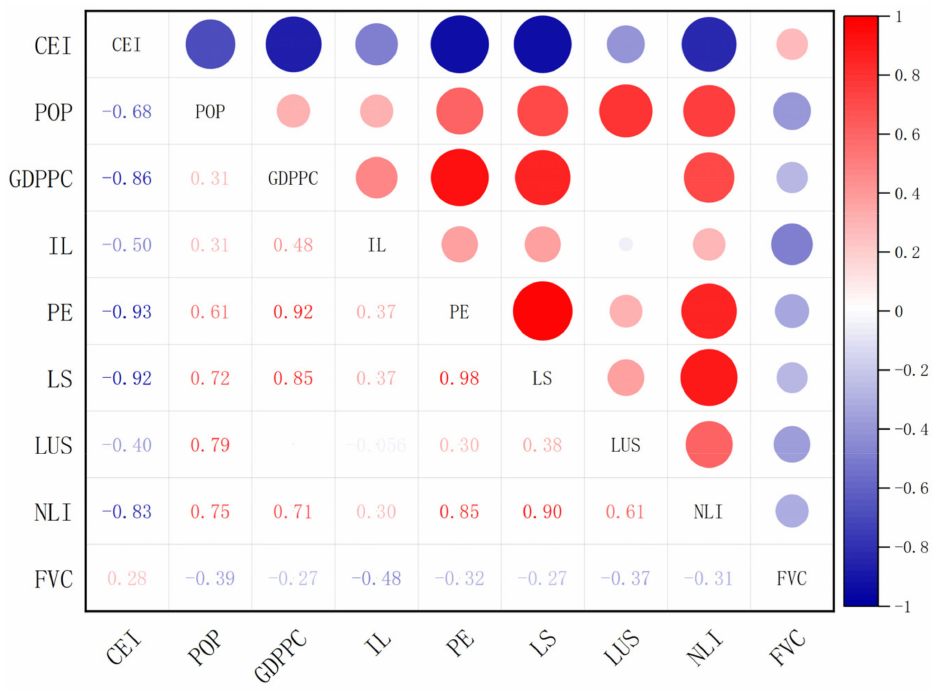
Figure 6. Results of the correlation test. Table 3. Estimation results of non-spatial panel data